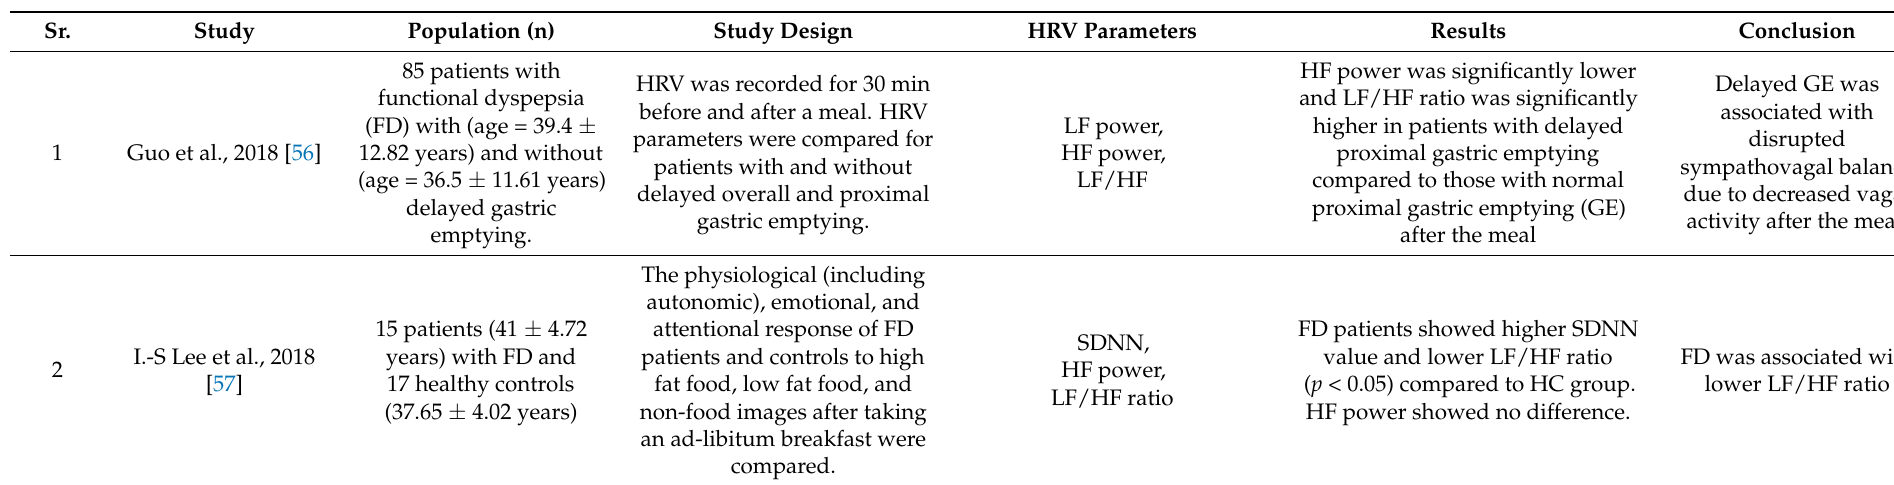
Table 3. Summary of Studies: Autonomic Nervous System and Functional Dyspepsia and Gastroparesis.